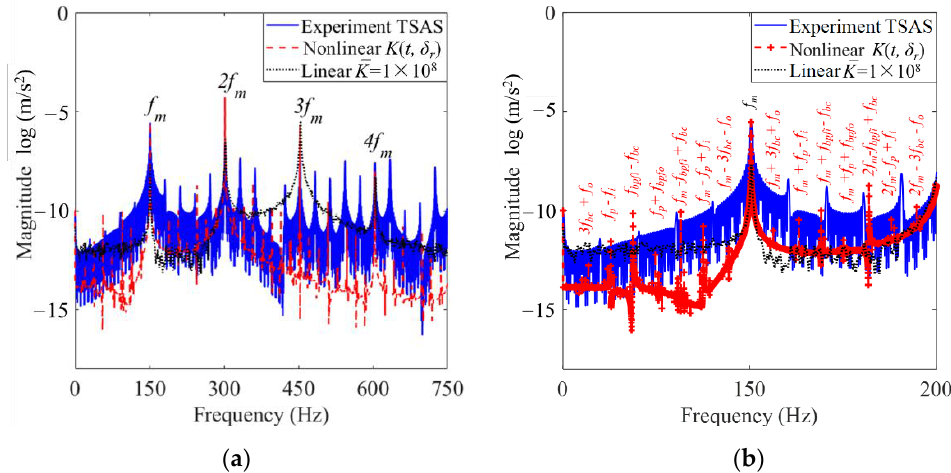
Figure 13. Frequency spectrum of the radial acceleration at 700 rpm/200 N · m: ( a ) broadband in the range of 0-750 Hz; ( b ) zoomed-in band in the range of 0-200 Hz.